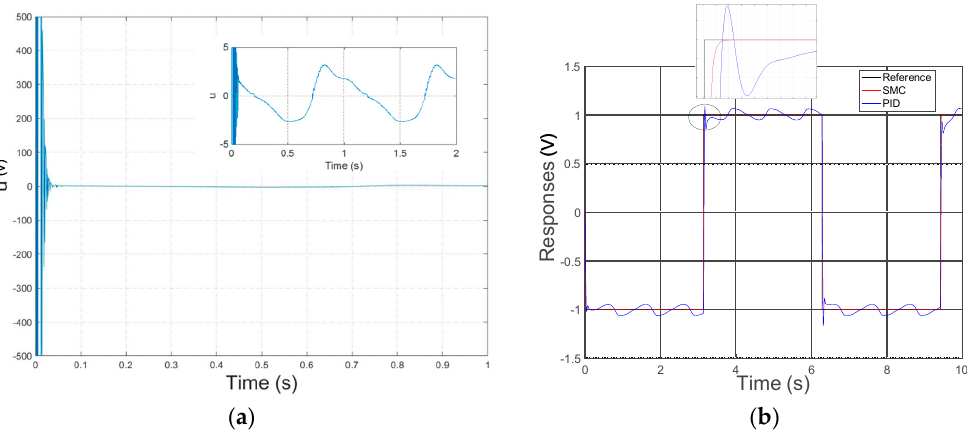
Figure 14. Output of the controller ( a ) and the comparison of step responses to a proportional- integral-derivative (PID) controller ( b